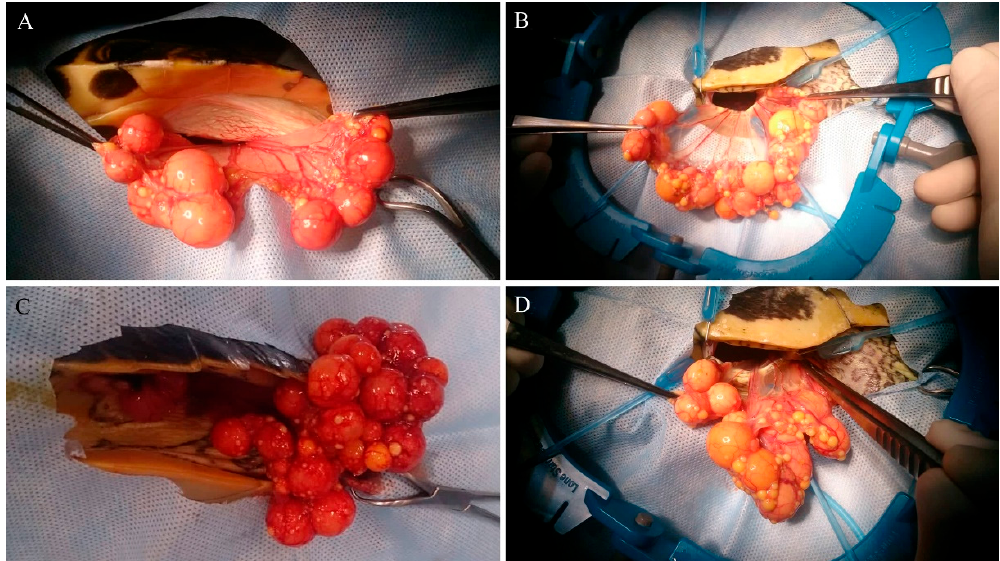
Figure 2. ( A ): Exteriorization of the left ovary from the left premoral fossa with the patient in right lateral recumbency. ( B ): Right ovary from the right premoral fossa with the patient in dorsal recumbency. ( C ): Right ovary from the left premoral fossa with the patient in right lateral recumbency. ( D ): Left ovary from the right premoral fossa with the patient in dorsal recumbency.